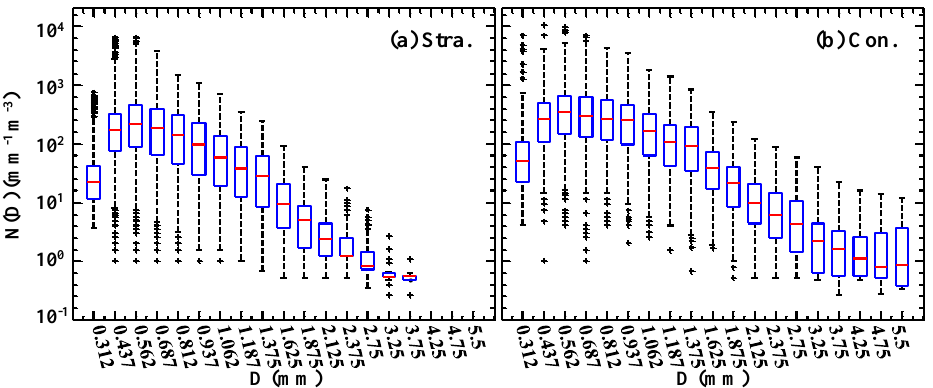
Figure 6. Boxplots of the DSDs for the stratiform ( a ) and convective ( b ) samples. D and N(D) are the raindrop diameter class and number concentration, respectively. The meaning of the boxplot is described in the caption of Figure 4.